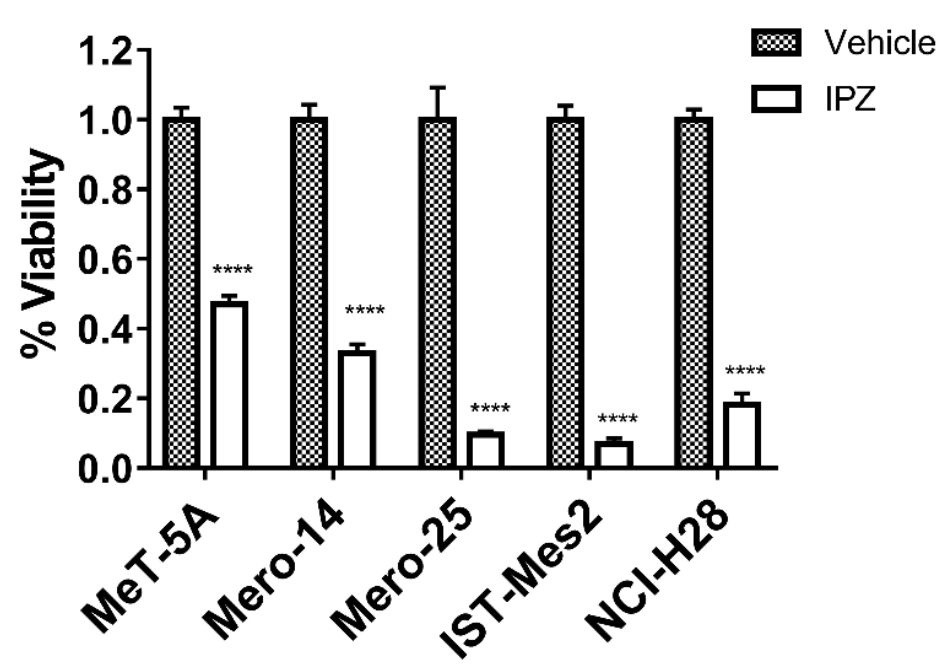
Figure 9. IPZ and cellular viability. Viability of MeT-5A and MPM cells when treated with the vehicle (DMSO, grey bar) or IPZ (white bar) for 72 h. Cell viability was determined using 3-(4,5-Dimethyl-2-thiazolyl)-2,5-diphenyl-2H-tetrazolium bromide (MTT) assay. Error bars are SEM from three